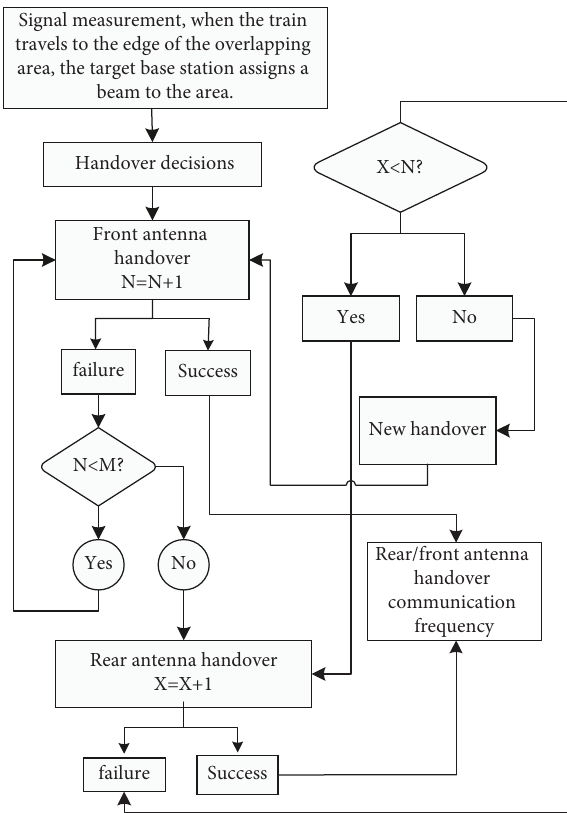
Figure 4: Operation of the proposed handover